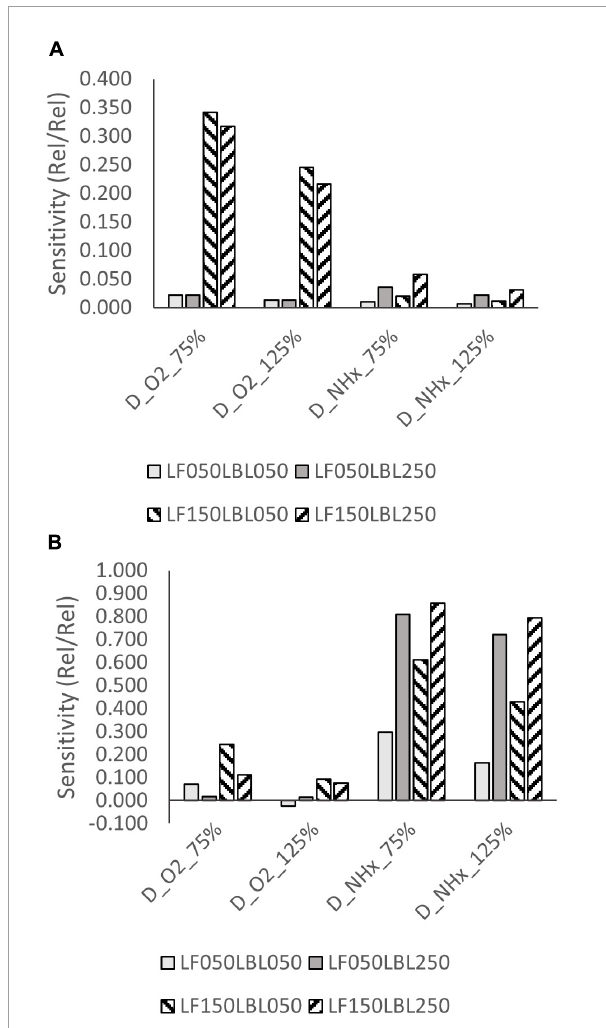
FIGURE7 Sensitivity of NH 4 + -N removal rate to the diffusivity constant of oxygen and ammonium at (A) 8 ◦ C and 35 mg/L, and (B) at 8 ◦ C and 0.1-1.0 mg/L NH 4 + -N